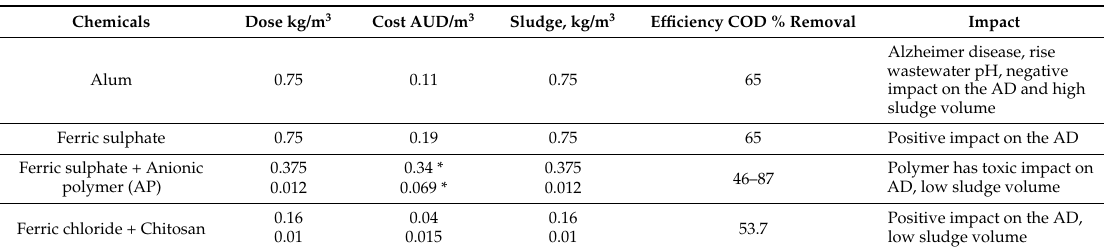
Table 18. Coagulants that have potential to be used in treating wastewater from the red meat processing